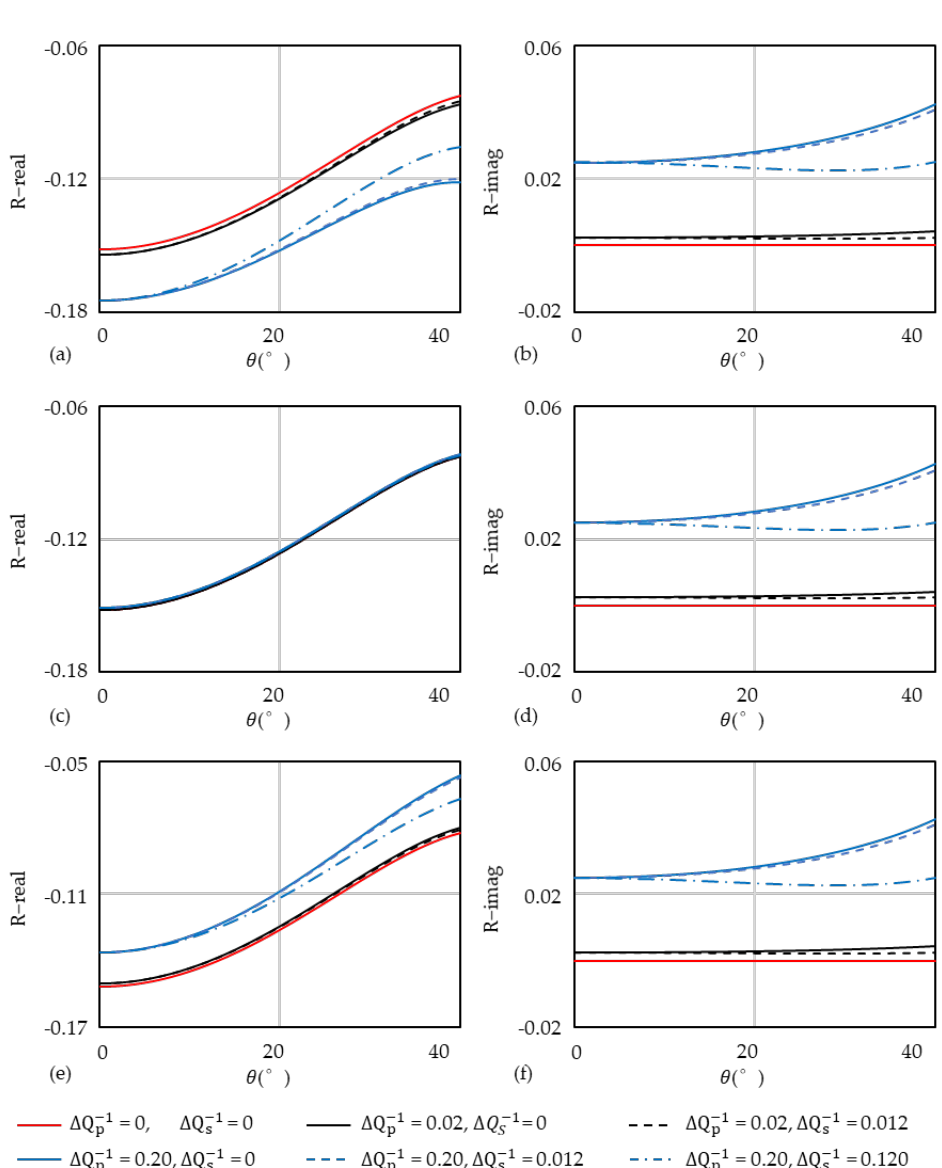
Figure 5. The effect of attenuation parameters ∆Q p−1 and ∆Q s−1 on the reflection coefficients. At this point, the reflection coefficients are complex numbers and frequency-dependent. ( a – f ) show the real part and imaginary part of reflection coefficients in three cases of 5 Hz, 25 Hz and 65 Hz separately. Different lines exhibit the results of six combinations of attenuation parameters. The reference frequency is set to 25